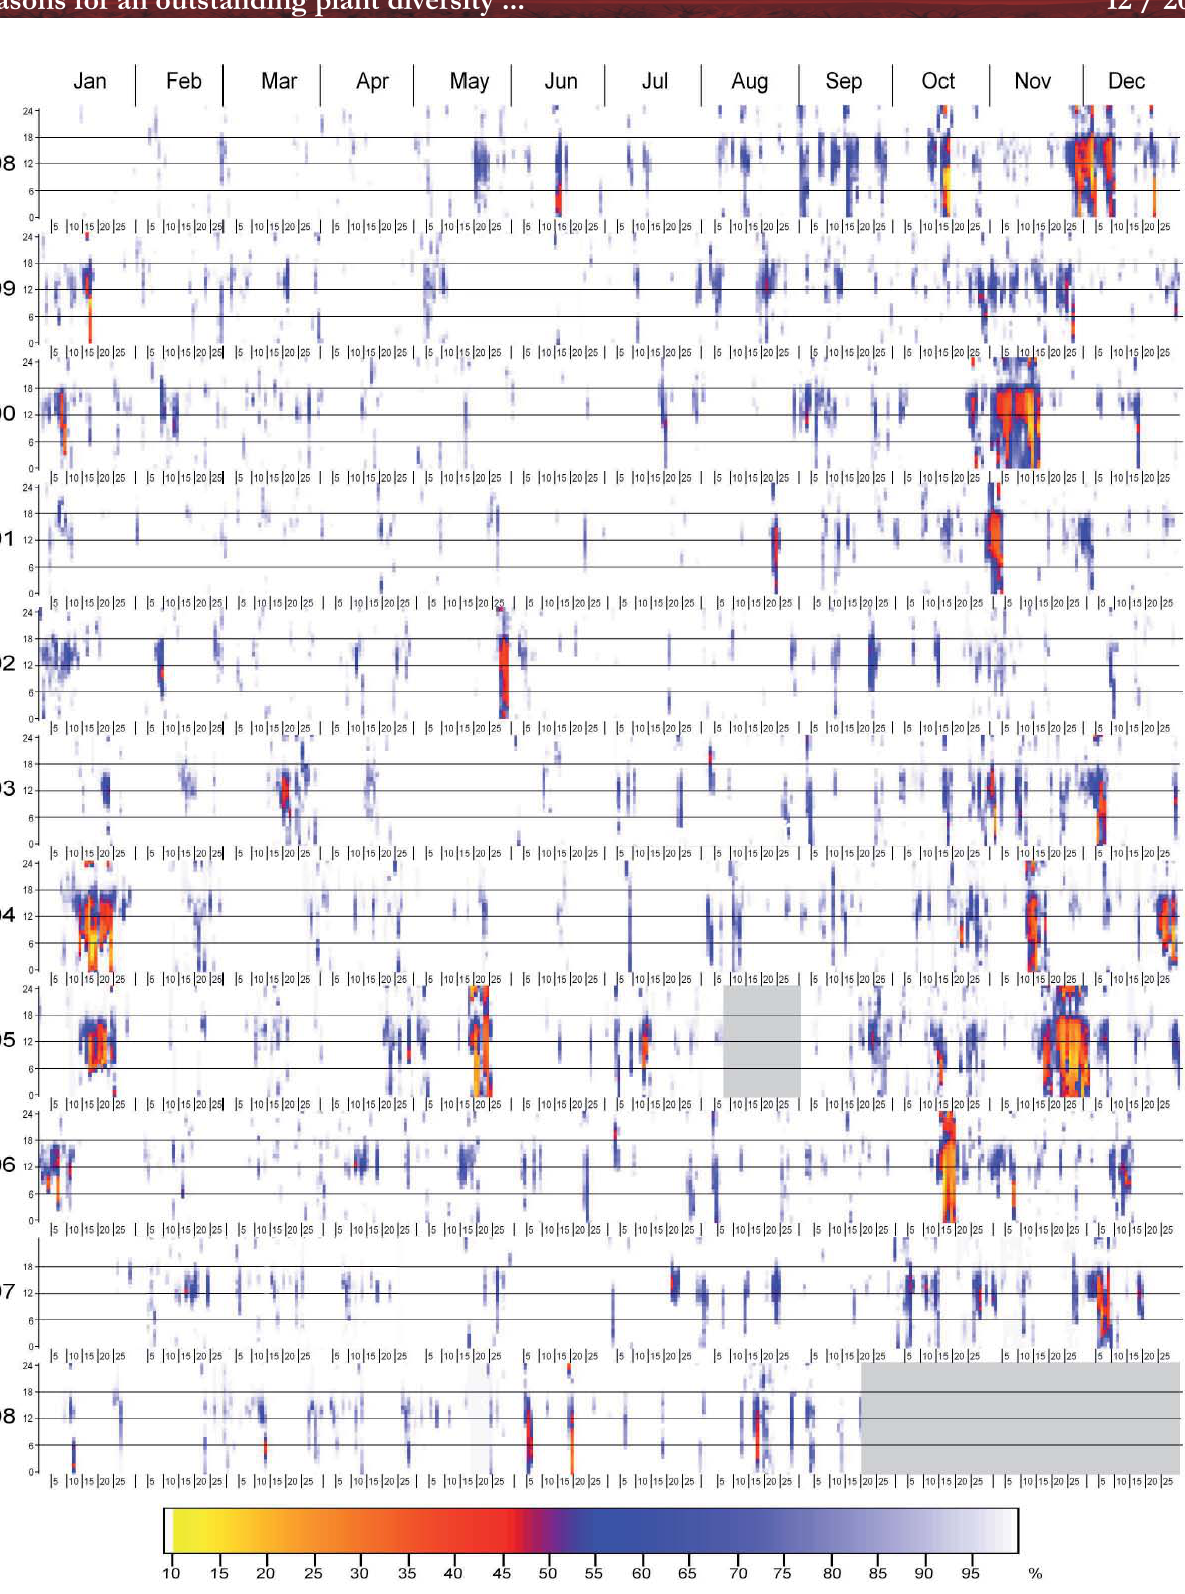
Figure 19: Long-term course of relative humidity on the crest of the Cordillera Real (climate station “Pára- mo” above Cajanuma, 3,400 m a.s.l.). The y-axis displays data of every hour of each day (x-axis); note the dry periods at the end of year 1998 (El Niño-year), 2000 and